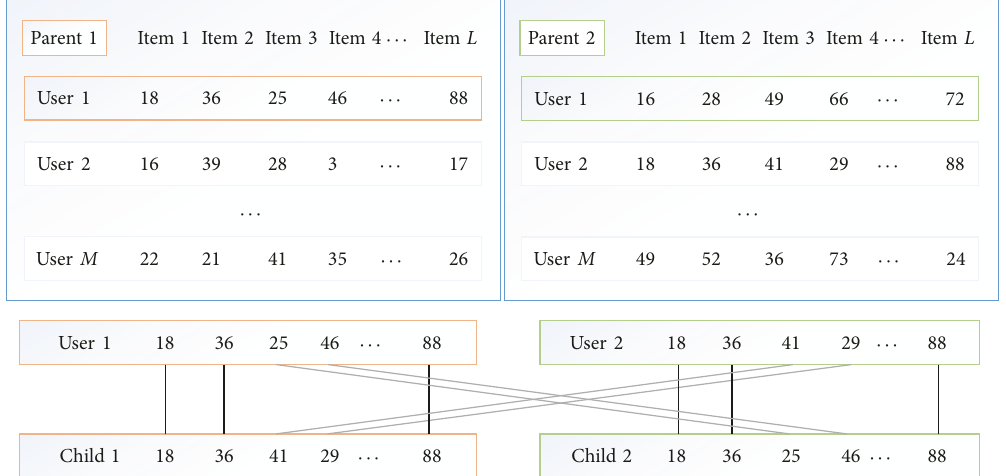
Figure 3: Illustration of crossover operator for two similar users on two parent solutions (Parent 1 and Parent